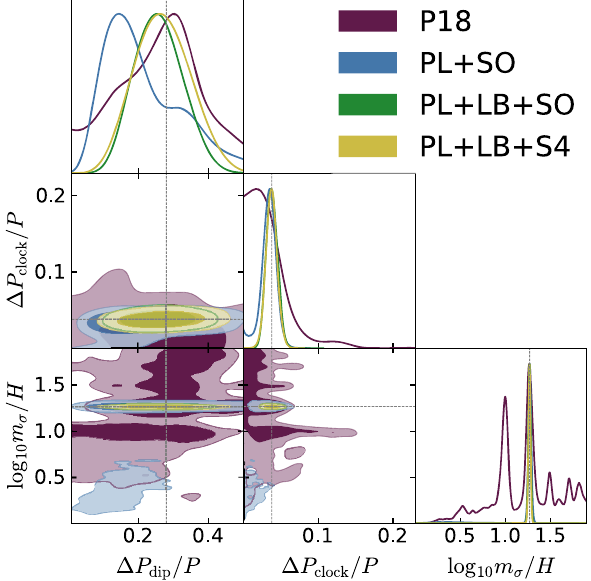
Fig. 3 Constraints from P18 and projected constraints on the param- eters characterizing the amplitude of the dip and the amplitude and frequency of the clock signal